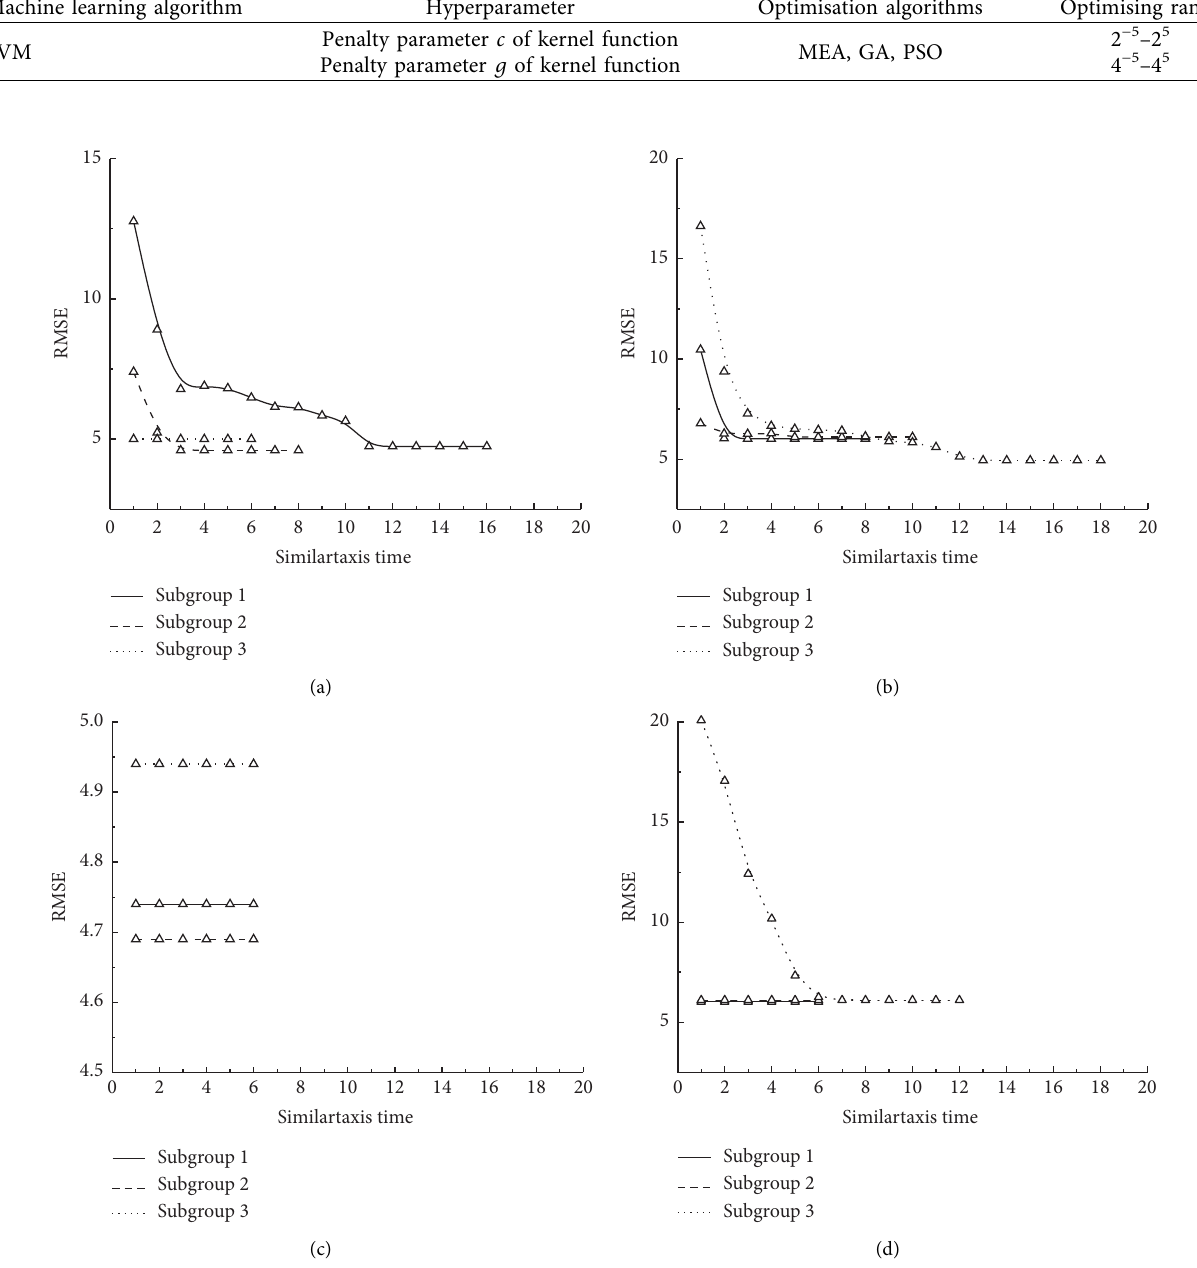
Figure 4: The evolution of RMSE during the similartaxis process. (a) Initial superior subgroups. (b) Initial temporary subgroups. (c) Superior subgroups after dissimilation operation. (d) Temporary subgroups after dissimilation